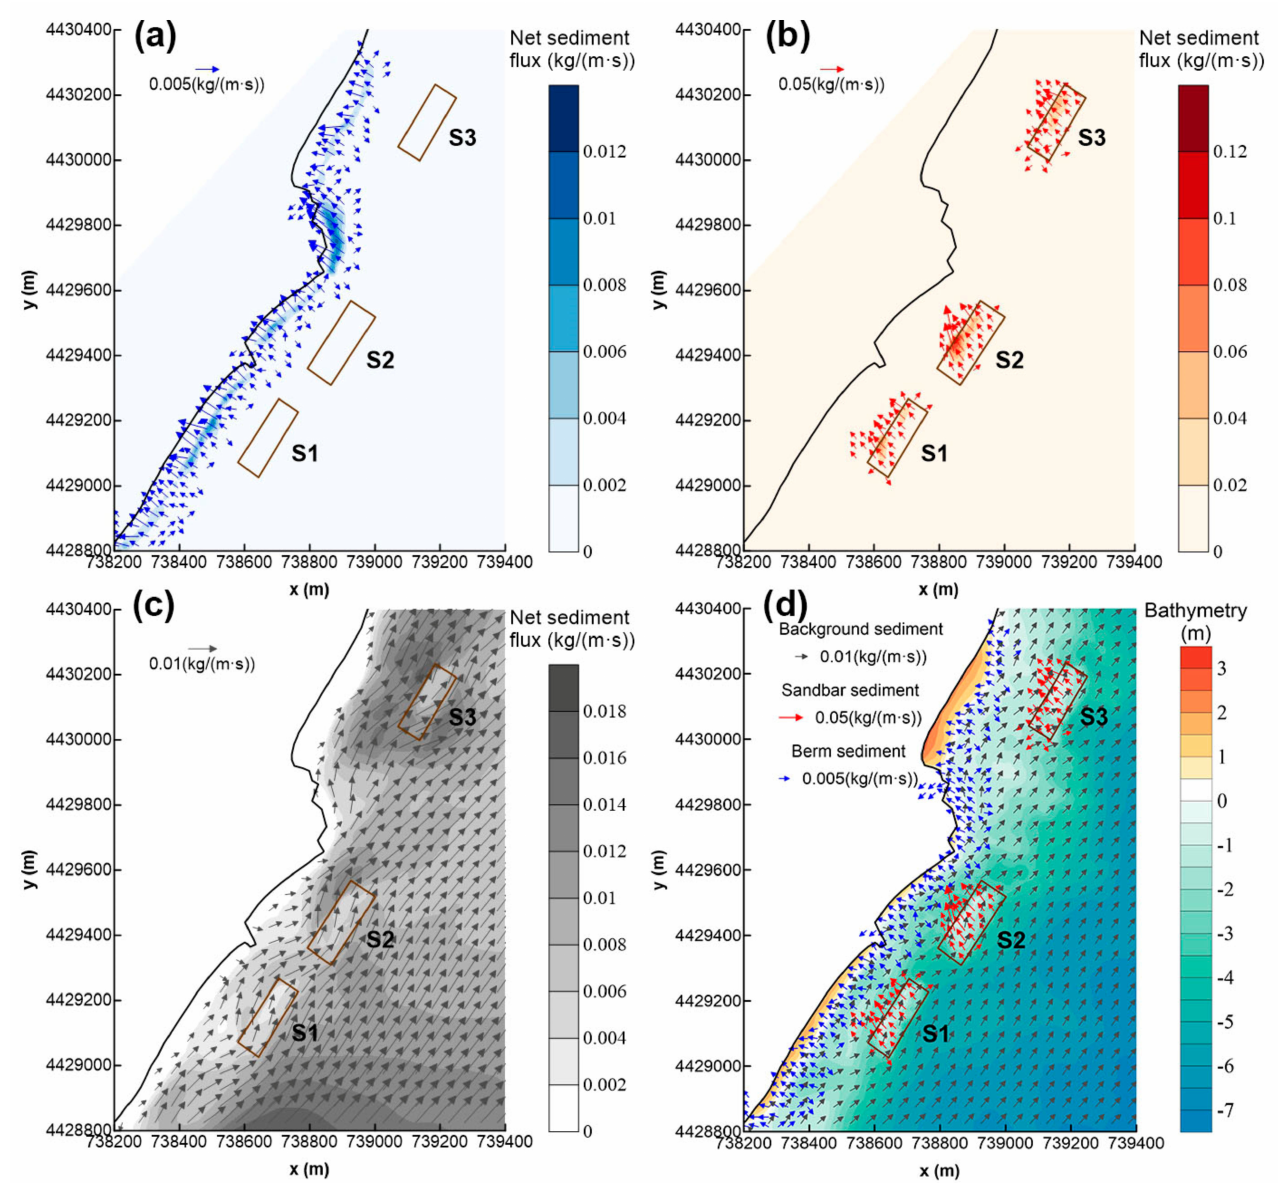
Figure 11. Net flux of ( a ) beach berm sediment, ( b ) sandbar sediment, and ( c ) background sediment under strong waves, and ( d ) overall view of the flux of three sediment fractions in a tidal cycle involving the strong wave moment (as in Figure